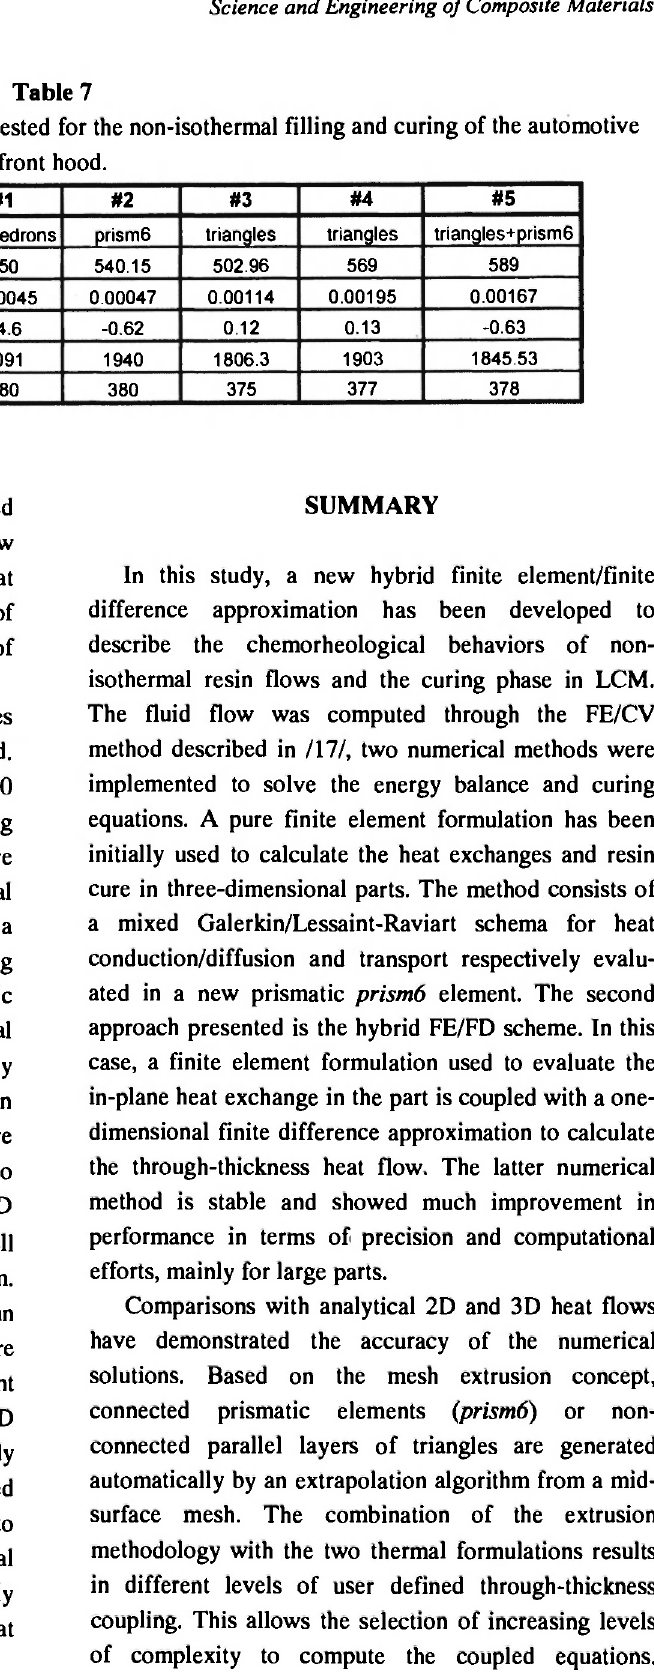
Comparison of results obtained with the five models tested for the non-isothermal filling and curing of the automotive front